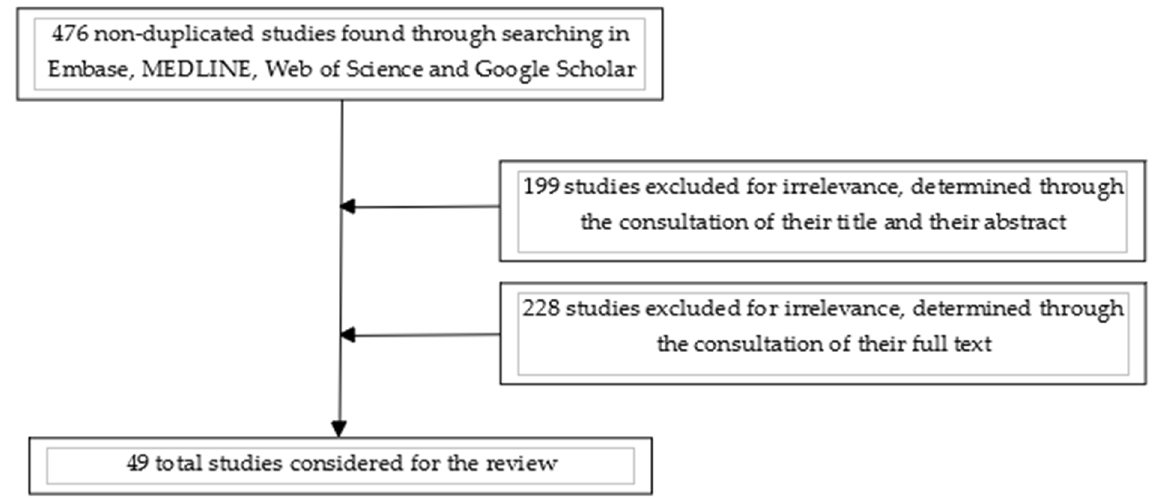
Figure 1. Diagram of the selection process of the cited articles.